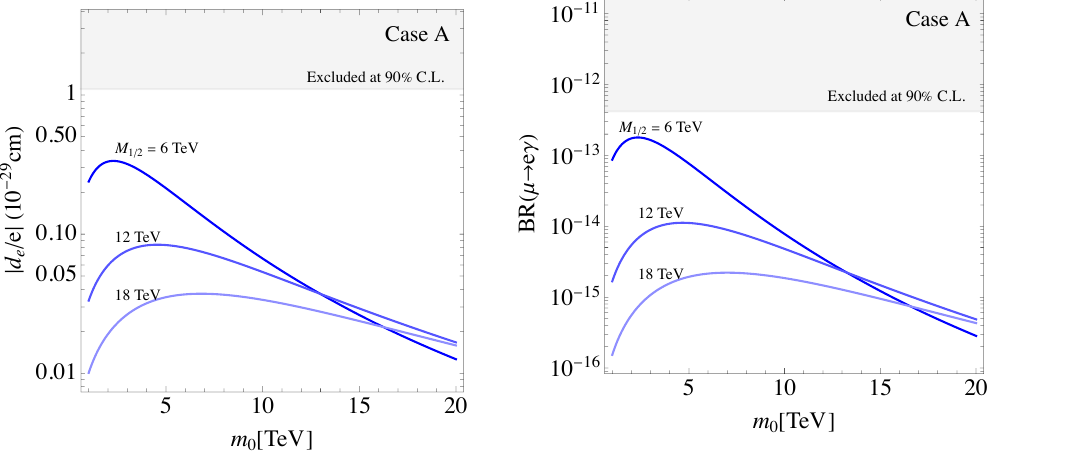
Figure 1 . The predicted | d e /e | versus m 0 with putting F τ = m 0 / 2 in case A. The grey region is excluded by the experimental upper bound.